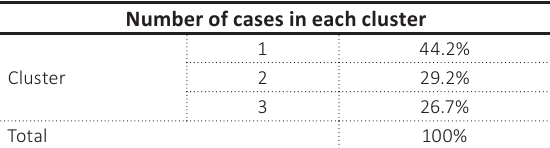
Table 5. Percent of cases in each cluster